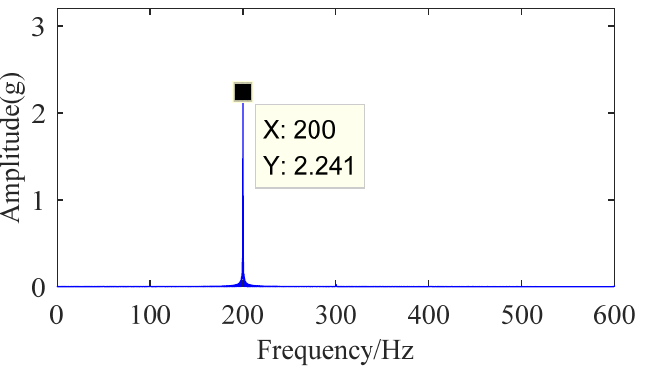
Figure 19. Vibration response of 304 stainless steel clamp with 200- μ m-thick hard coating of Z r O 2 - PTFE under 200 Hz fixed-frequency excitation.